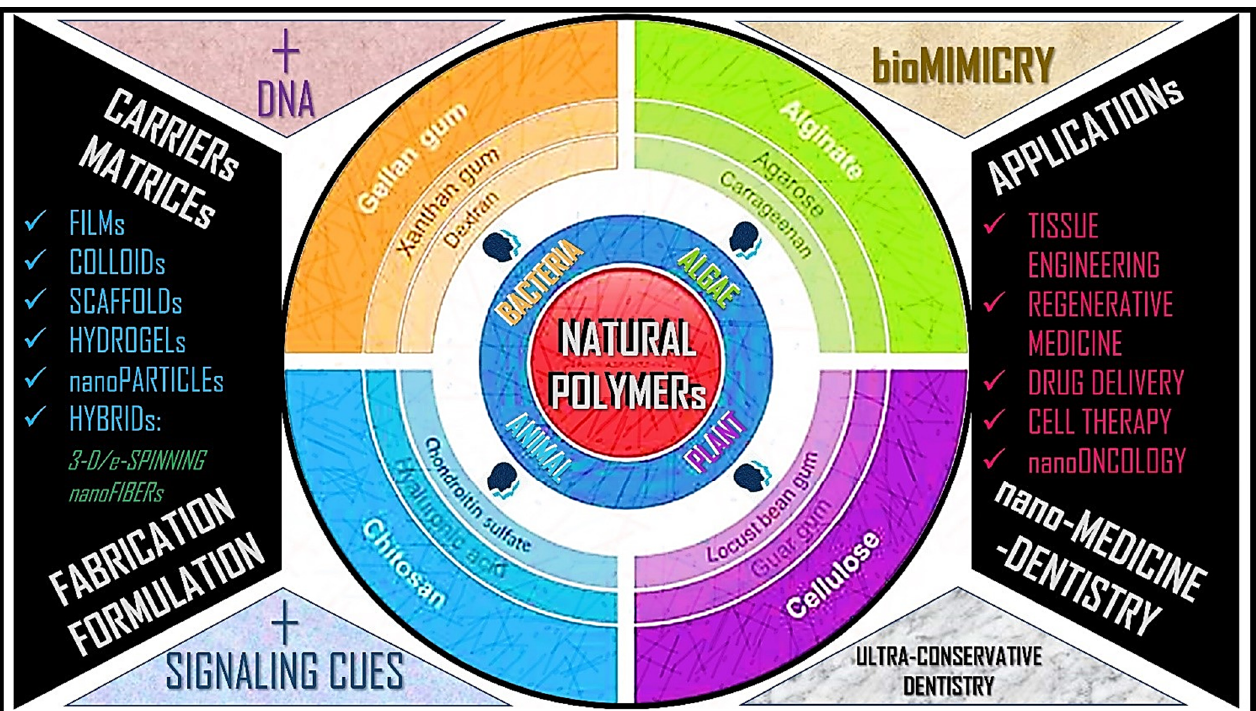
Figure 3. Bio-inspired/-mimetics polymers for muco-adhesive drug delivery, and beyond.